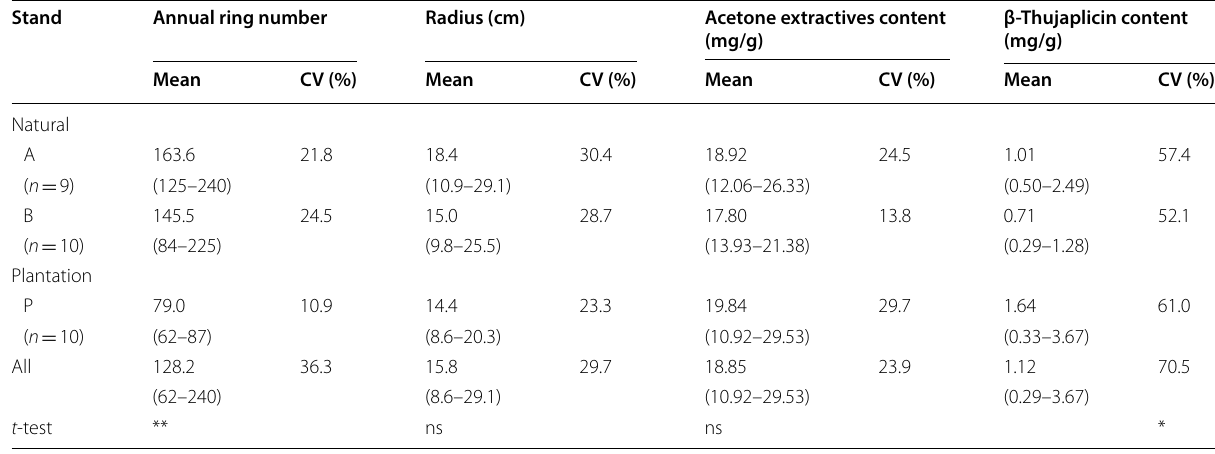
Values in parentheses are minimum and maximum values n , number of sample trees; CV, coefficient of variation **, *, and ns indicate significant differences ( p < 0.01 and p < 0.05) and no significant difference ( p > 0.05) between the stands by the t -test, respectively. The t -test was conducted to detect the differences between natural (combined data of stands A and B) and plantation stands